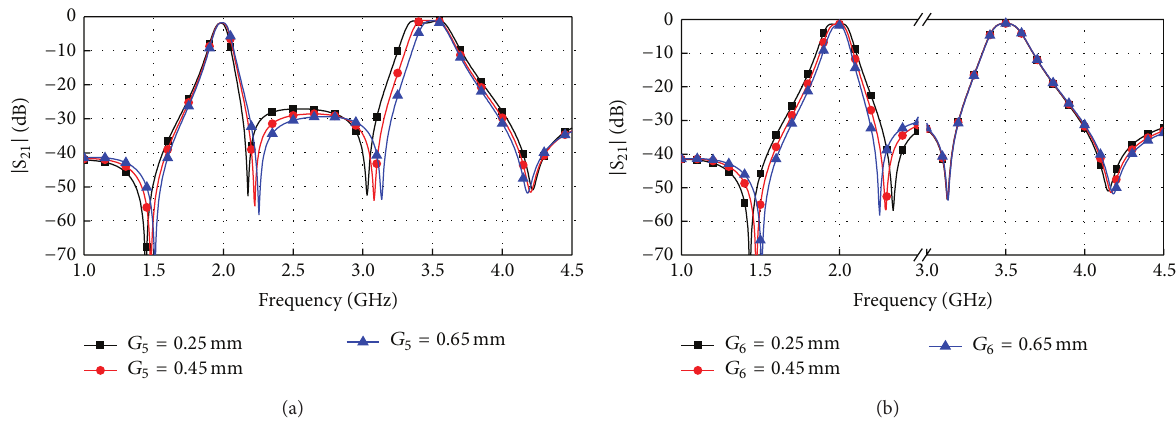
Figure 6: Simulated | S 21 | against (a) 𝐺 5 ; (b) 𝐺 6 (the varactors are deleted and replaced by capacitors with value of 3 pF).